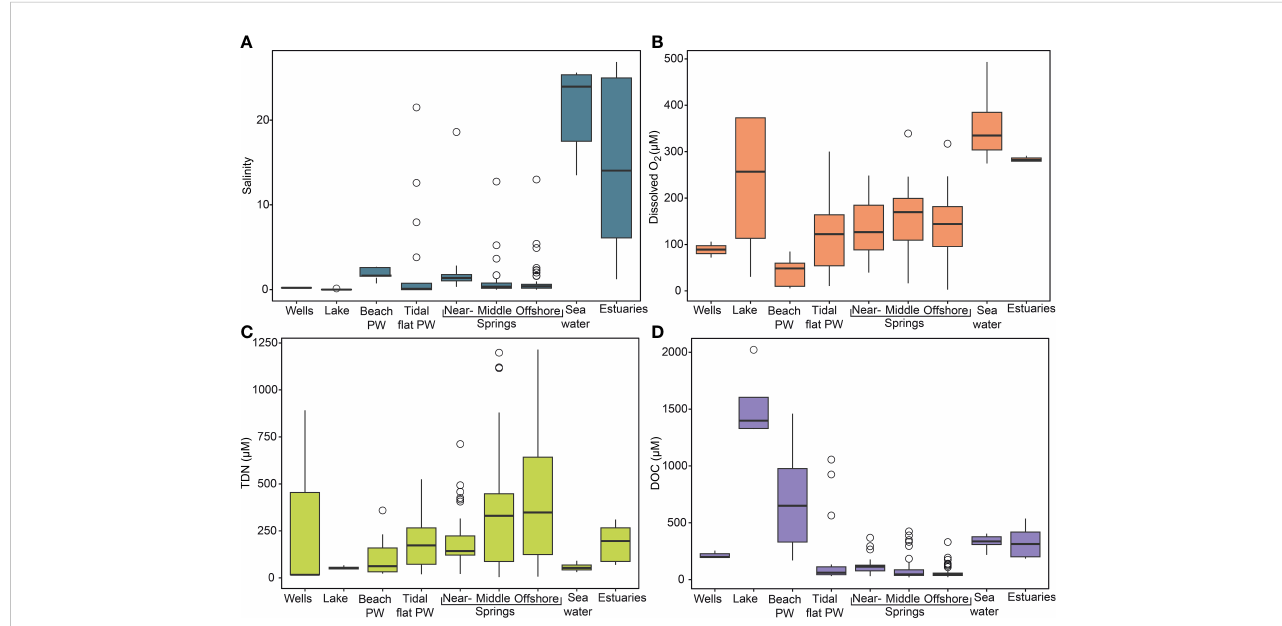
FIGURE 2 Physicochemical data for Sahlenburg tidal fl at endmembers. (A) salinity, (B) oxygen concentrations, (C) TDN concentrations, (D) DOC concentrations. PW,